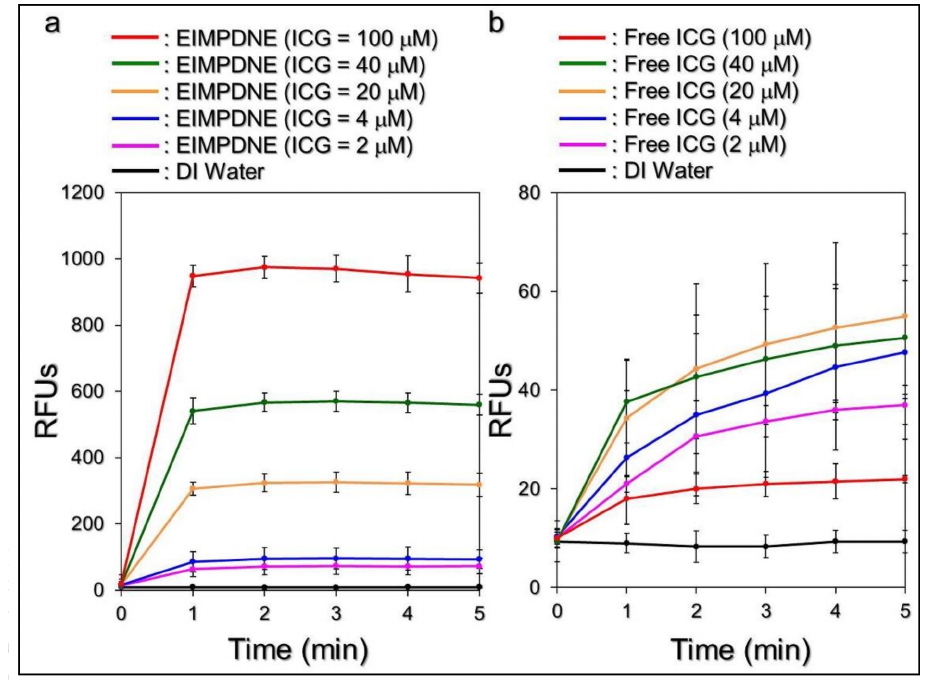
Figure 7. Assessments of EIMPDNE and freely dissolved ICG-induced singlet oxygen productions under light illumination. Upon NIR laser exposure (808 nm; 6 W cm − 2 ), the yields of singlet oxygen generated from the EIMPDNEs ( a ) and freely dissolved ICG ( b ) with equal ICG concentrations of 0 (DI water only), 2, 4, 20, 40, and 100 µ M were separately measured every 60 s for 5 min. The amount of singlet oxygen produced in each group was evaluated based on the intensity of SOSG-induced fluorescence detected using a spectrofluorometer with a 488 nm excitation wavelength and 525 nm emission wavelength, and was represented by RFUs. Values are mean ± s.d. ( n =